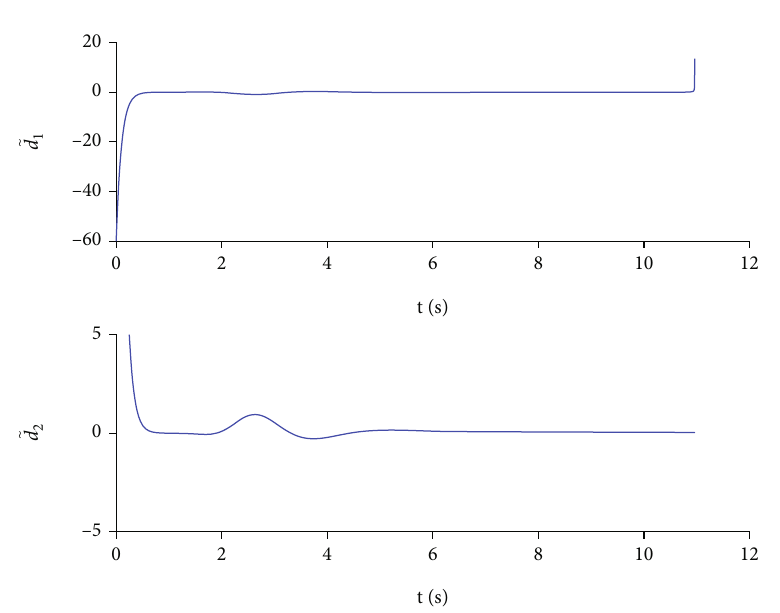
Figure 12: Variation curve of auxiliary variables.